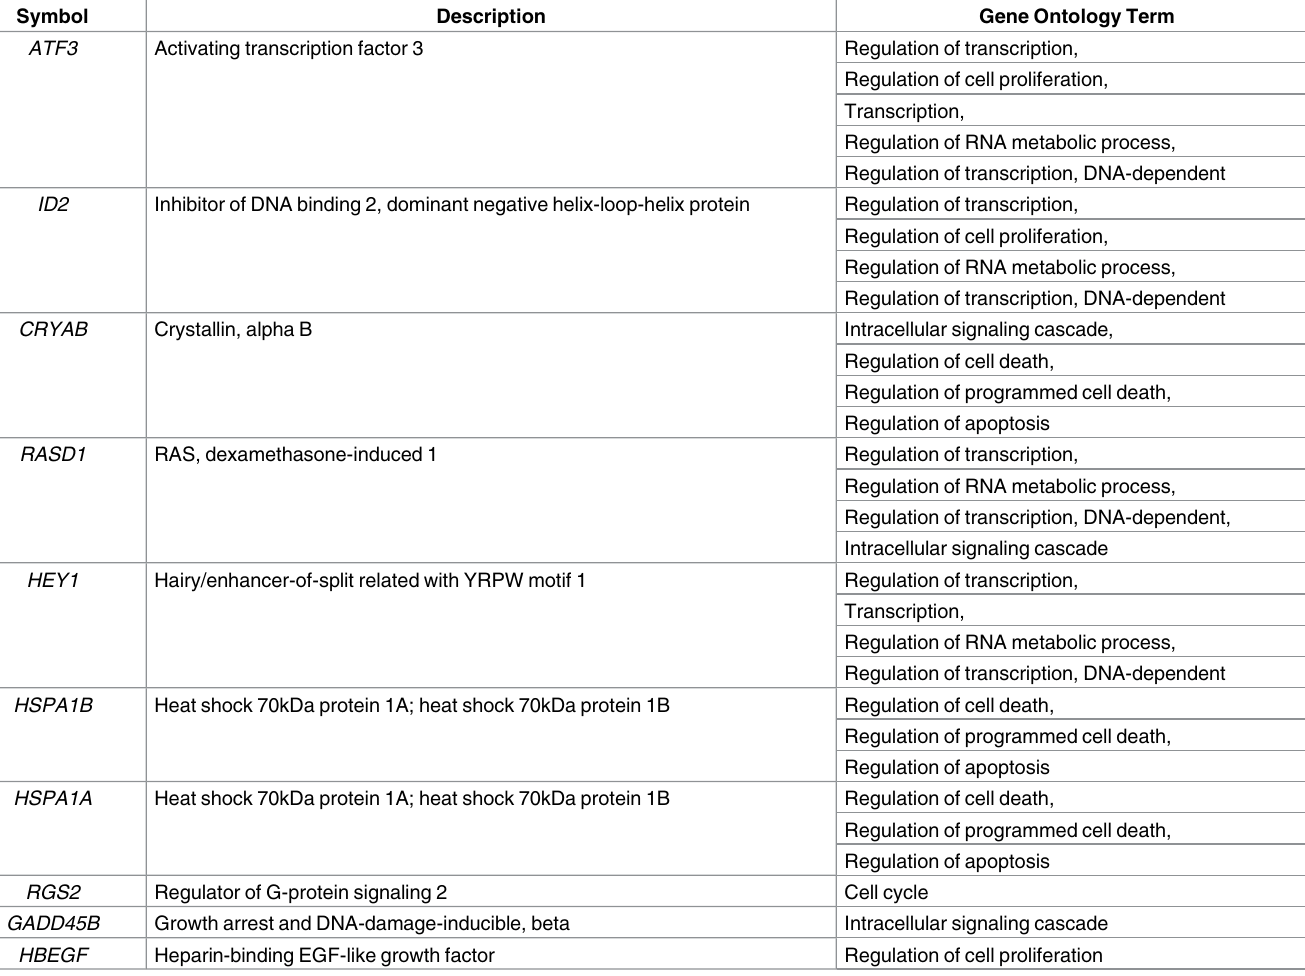
Table 1. The 10 most up-regulated genes found with BP analysis following GE treatment.